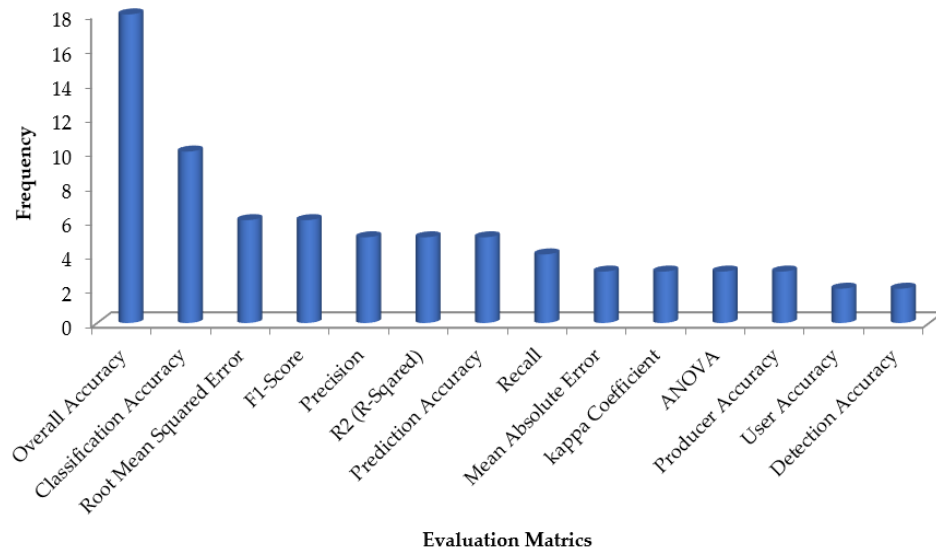
Figure 8. Most frequent evaluation parameters.